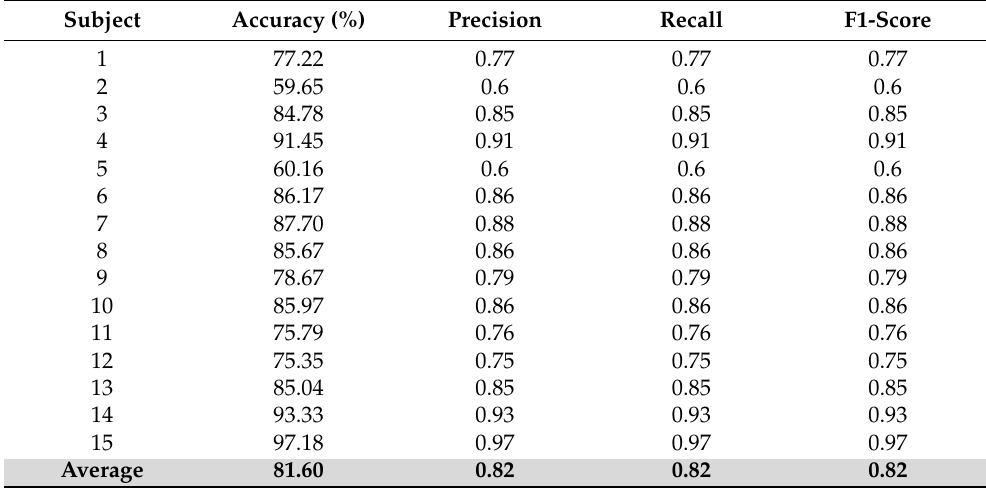
Figure 8. Trend chart showing an increase in accuracy (in %) with an increase in window size. Table 7. Subject-wise results for SEED-IV dataset (4 classes) using 3D-CNN + ELM model.